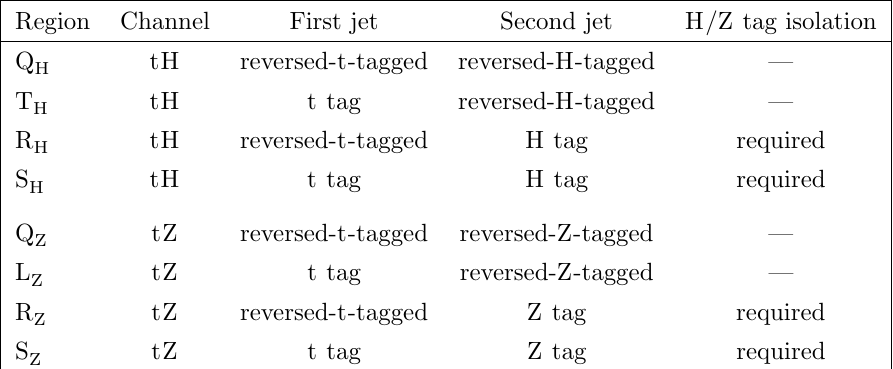
, T , R , S , Q , H H H H Z T